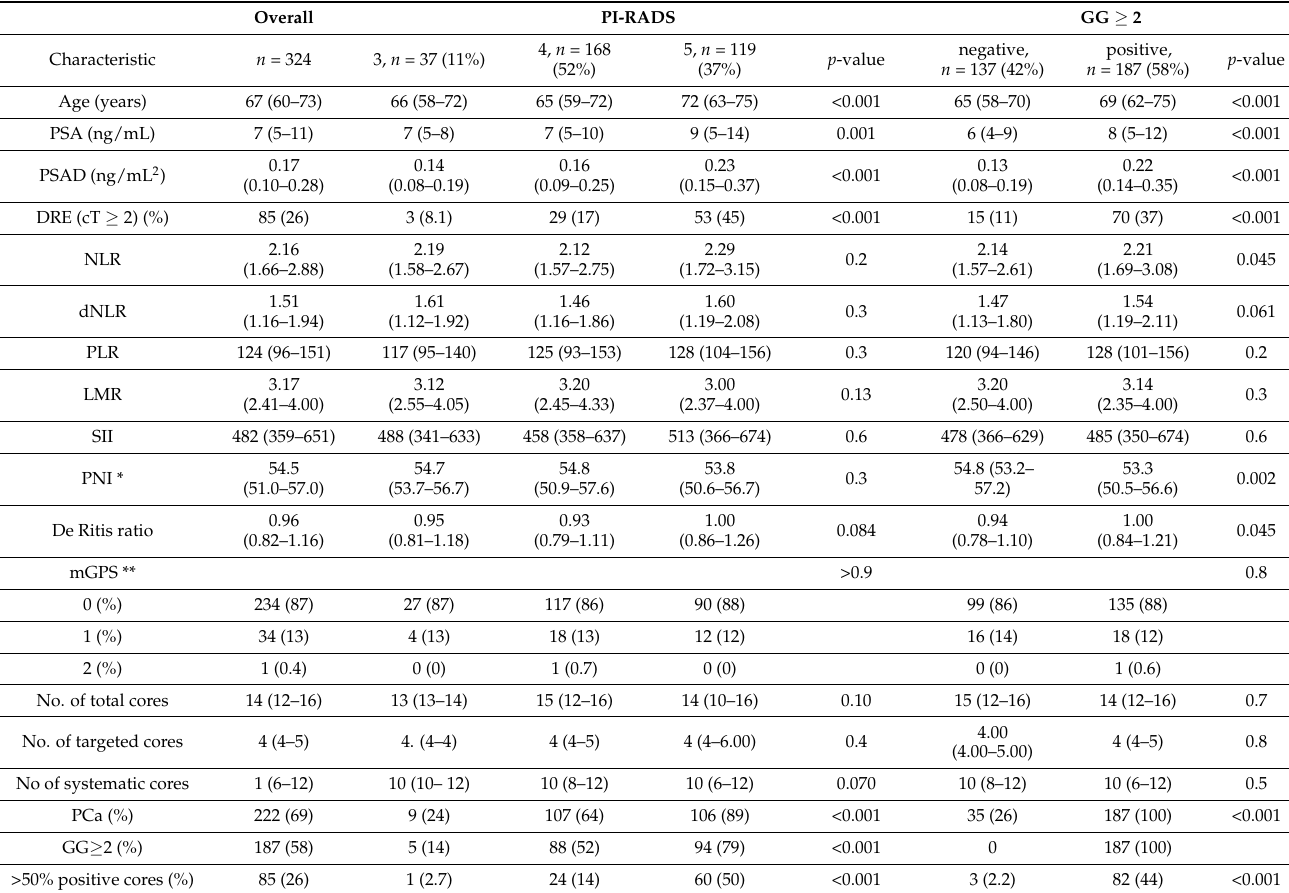
Table 1. Consecutive patients with PI-RADS ≥ 3 lesions undergoing MRI.